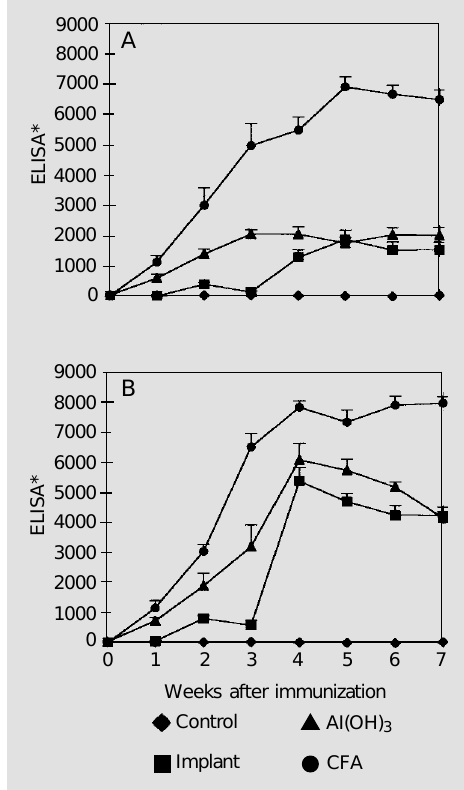
Figure 1 - Humoral immune re- sponses elicited by Ova-conju- gated implanted sponges. A , For the primary immune response, Swiss mice were immunized with Ova in Al(OH) 3 (10 µg, ip ) or in complete Freund’s adjuvant (CFA) (100 µg, sc ), or were im- planted subcutaneously with Ova-coupled sponges. Controls were either injected with 10 µg of Ova in saline, ip , or implanted with sponges treated without Ova. B , For the secondary im- mune response, the above pro- tocol was repeated but mice re- ceived 10 µg of Ova diluted in saline, ip , during week 3 as a booster. Anti-Ova antibodies were detected by ELISA. Data are reported as ELISA* score, which represents the mean ± SEM (N = 5-7) of the sums of absorbance values from serum dilutions of